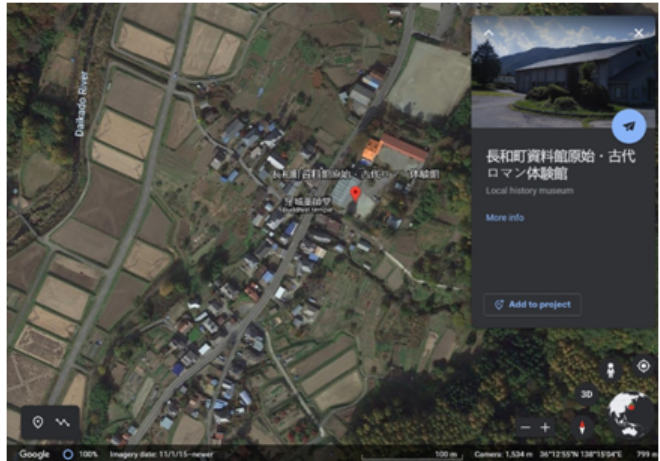
Figure 2: Example of supporting the Japanese language learning for future Japanese language teachers by using of the Google Earth